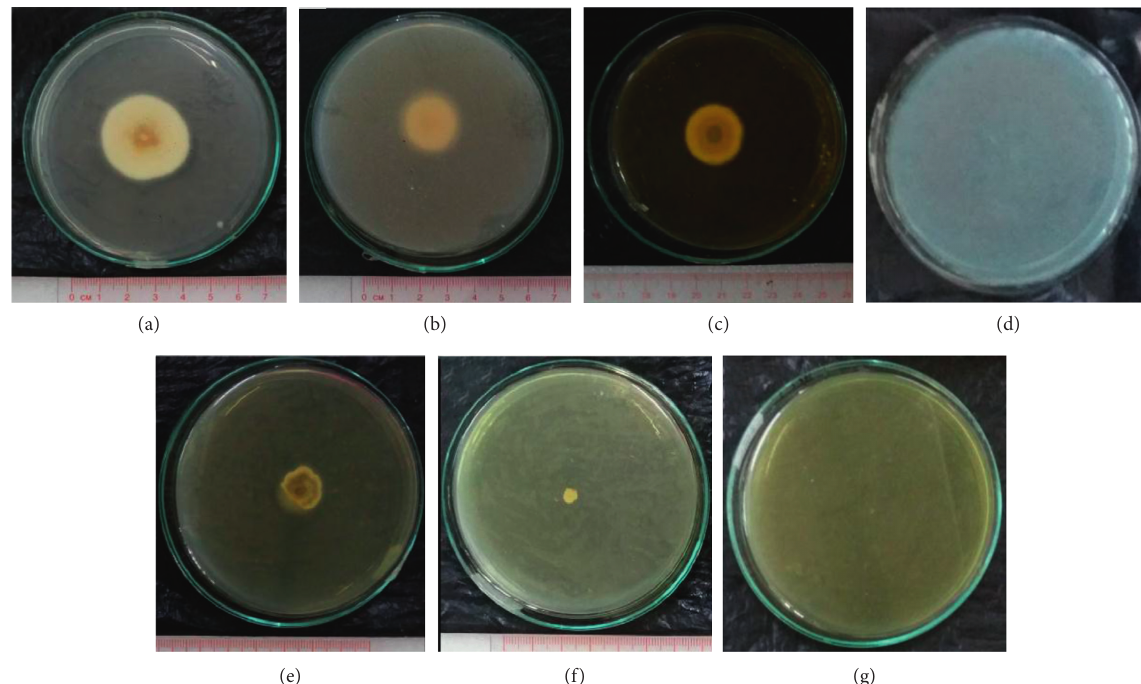
Figure 7: C. gloeosporioides colonies after 10 days of growth on nutrient agar containing (a) blank; (b) 20% mango flesh; (c) 2200ppm AA; (d) 500ppm CuSO 4 ; (e) 100ppm CuNPs; (f) 150ppm CuNPs; (g) 200ppm CuNPs.